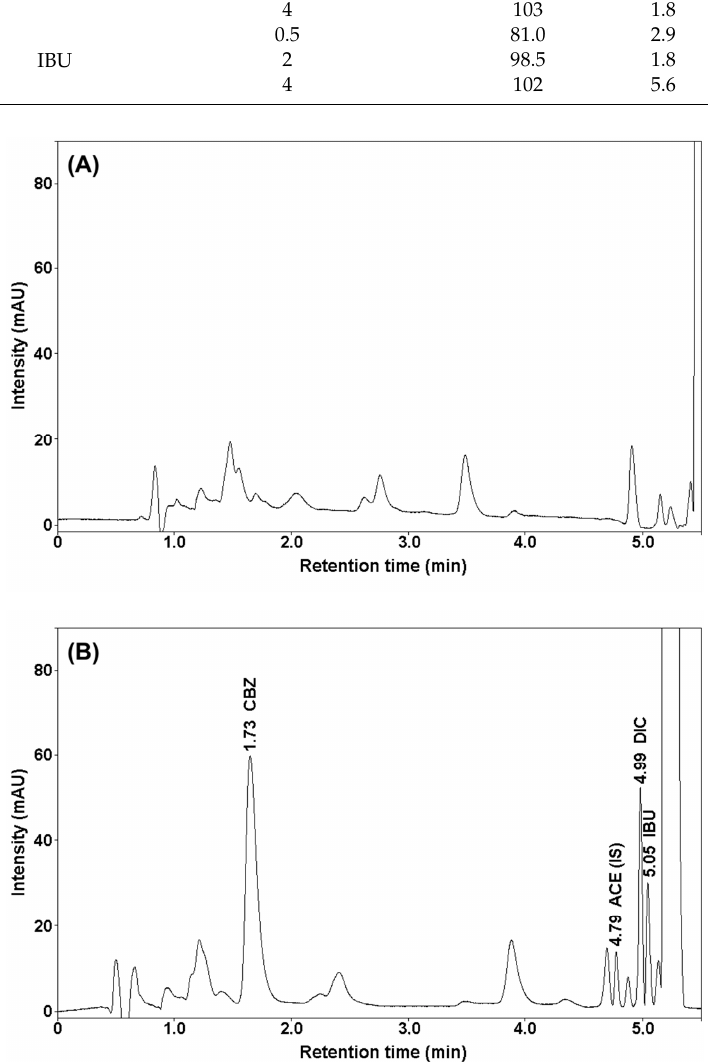
Figure 4. Chromatograms of bottom sediment sample extracts: ( A ) without added standards (blank sample), ( B ) spiked with drugs obtained after SUPRAS microextraction.